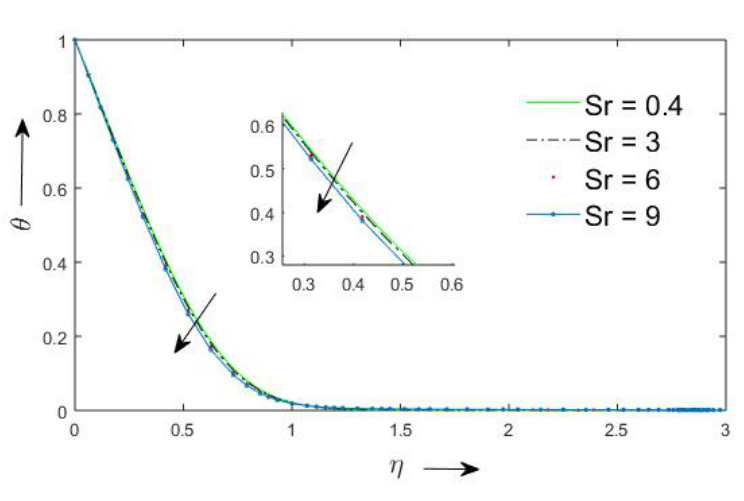
Figure 3: Changes in temperature as a consequence of Sr